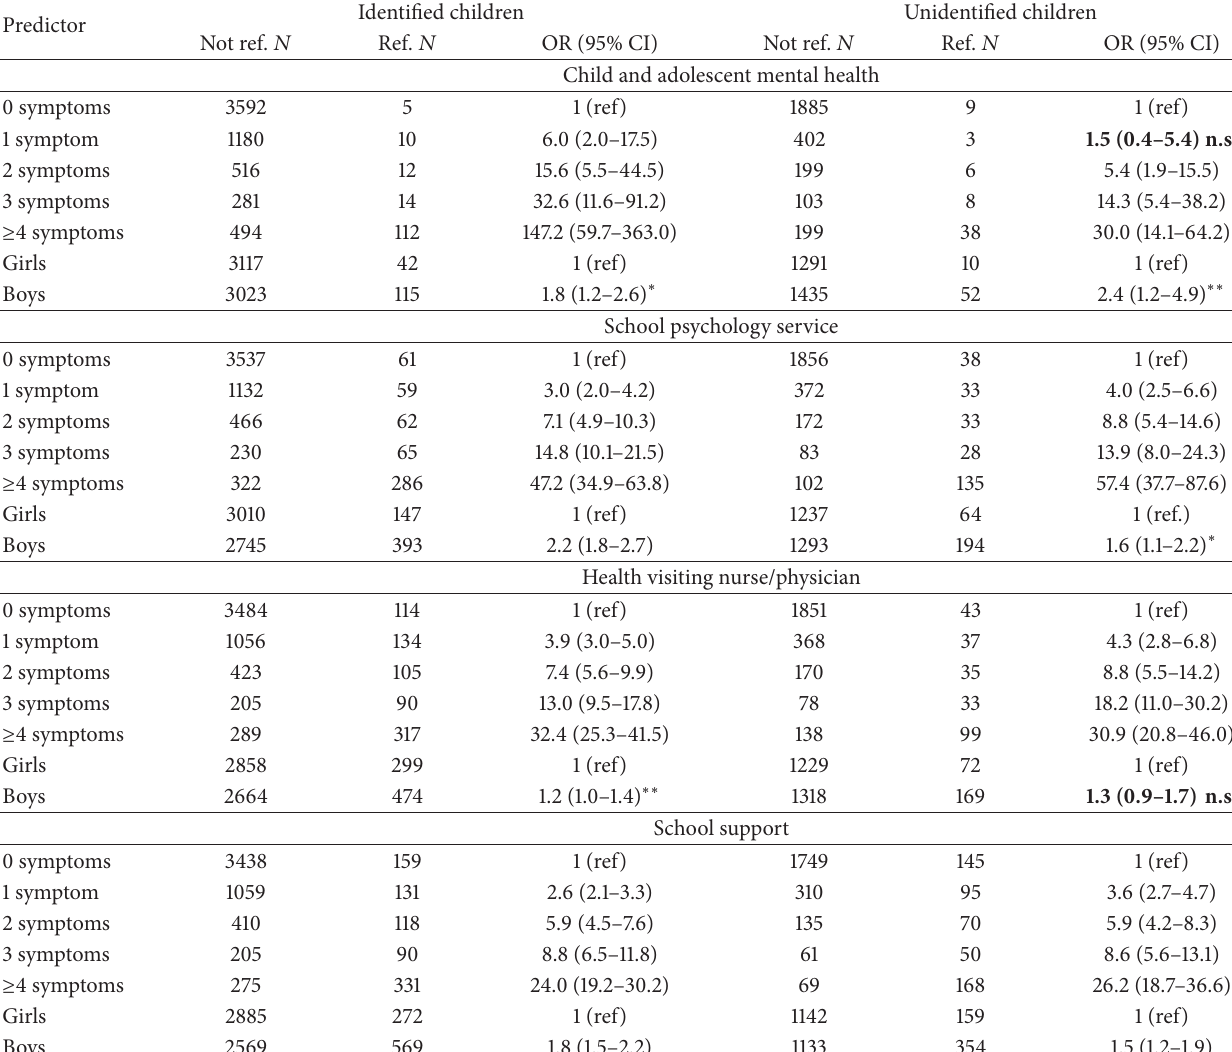
Table 5: Logistic regression analyses showing odds ratios (OR) for services with number of symptoms and gender as predictors, for identified and unidentified children